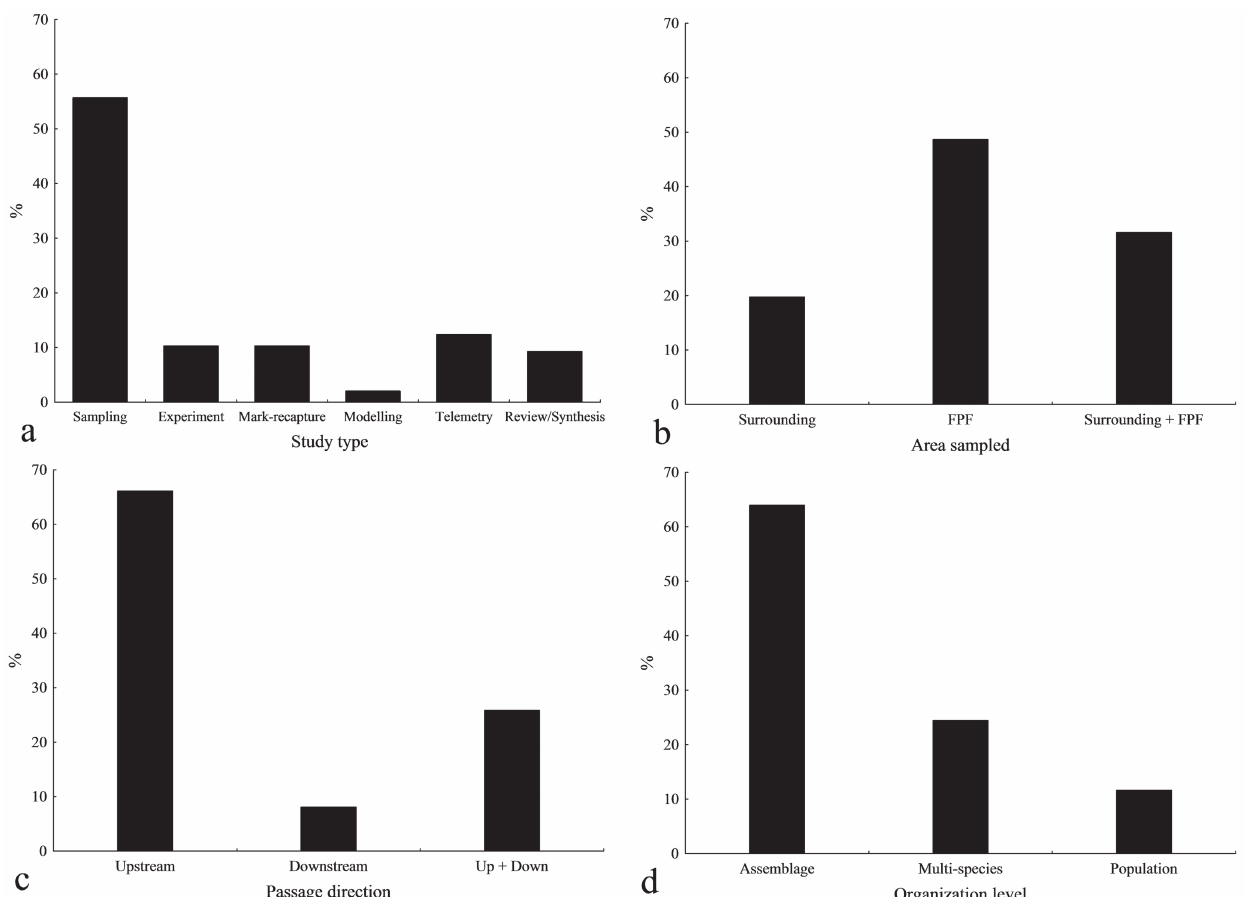
Fig. 6. Profile of studies that investigated fish passage facilities in South America. a. type of study; b. area sampled; c. passage direction; d. level of biotic